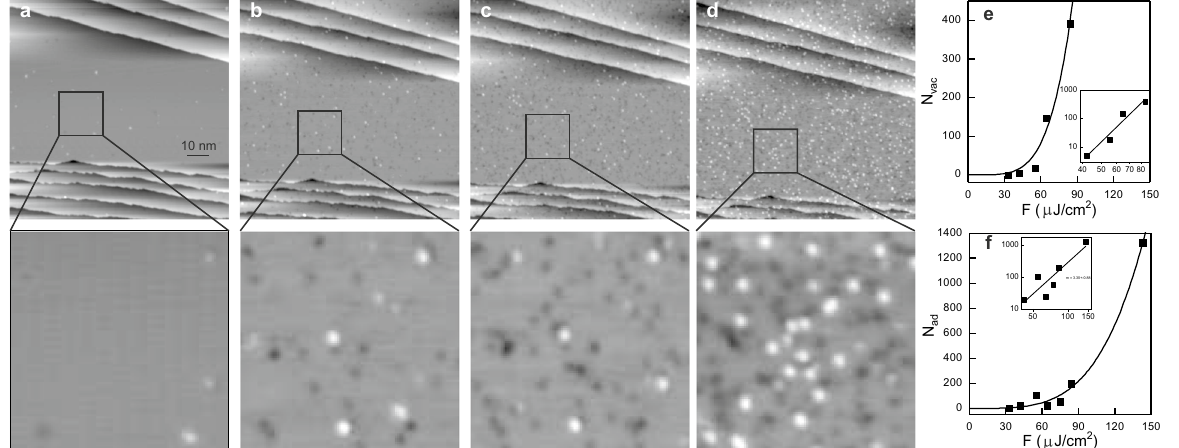
Figure 6. Fluence dependence: ( a – d ) Series of laser illuminations of the same surface region with increasing fluence; lower row: Zoom-in into the square marked in the upper row at enhanced contrast; 10 7 pulses at absorbed SPP fluences: ( a , b ) 43 µ J/cm 2 ( b , c ) 63 µ J/cm 2 ( c , d ) 136 µ J/cm 2 ; V t = 130 mV , I t = 55 pA [Note that the laser alignment to the tip-sample region, though performed at much reduced fluence, leads already to theformation of a minor number of defects.]; ( e , f ) newly formed clusters (cid:31) N i per 1000 nm 2 , insets: same data on double-logarithmic scale with apparent linear fit: ( e ) vacancies ( f )